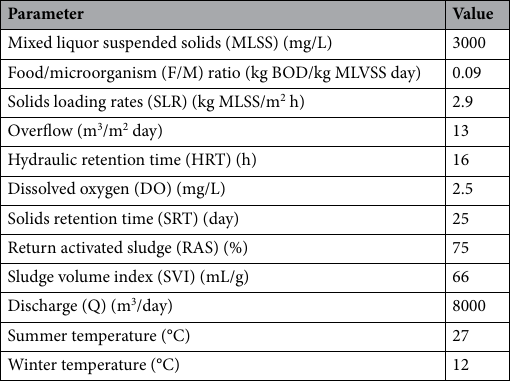
Table 1. Operational conditions of MASTP-EAAS.